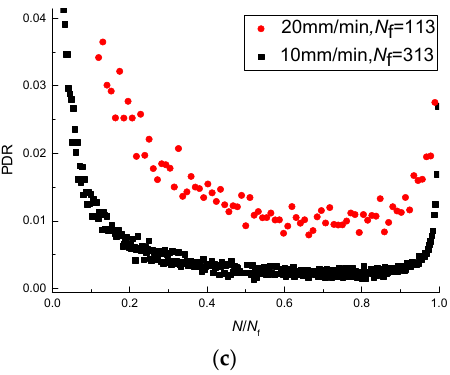
Figure 10. PDRs under different test conditions: ( a ) PDRs at different stress-strength ratios; ( b ) PDRs at different temperatures; ( c ) PDRs at different loading rates.